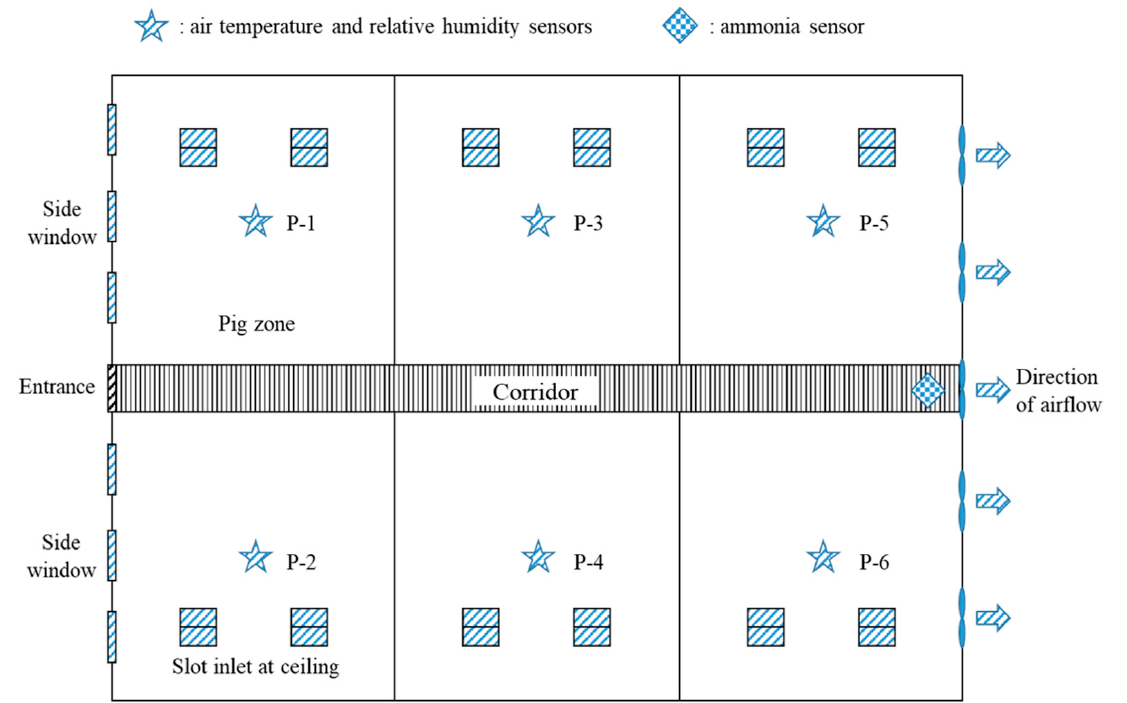
Figure 4. Sensor locations for monitoring the environmental factors inside the experimental fattening pig house.